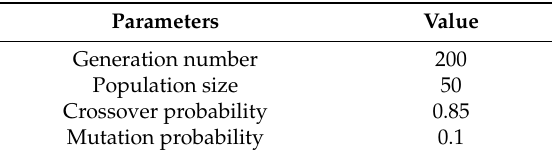
Table 3. Parameter settings used in GA.